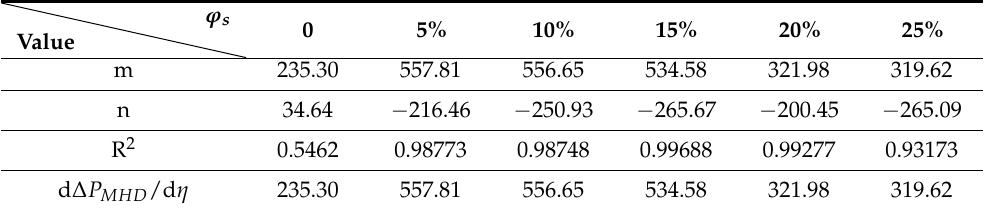
Table 2. Parameters related to fitting curve of magnetic fluid pressure drop ∆ P MHD and kinematic viscosity η